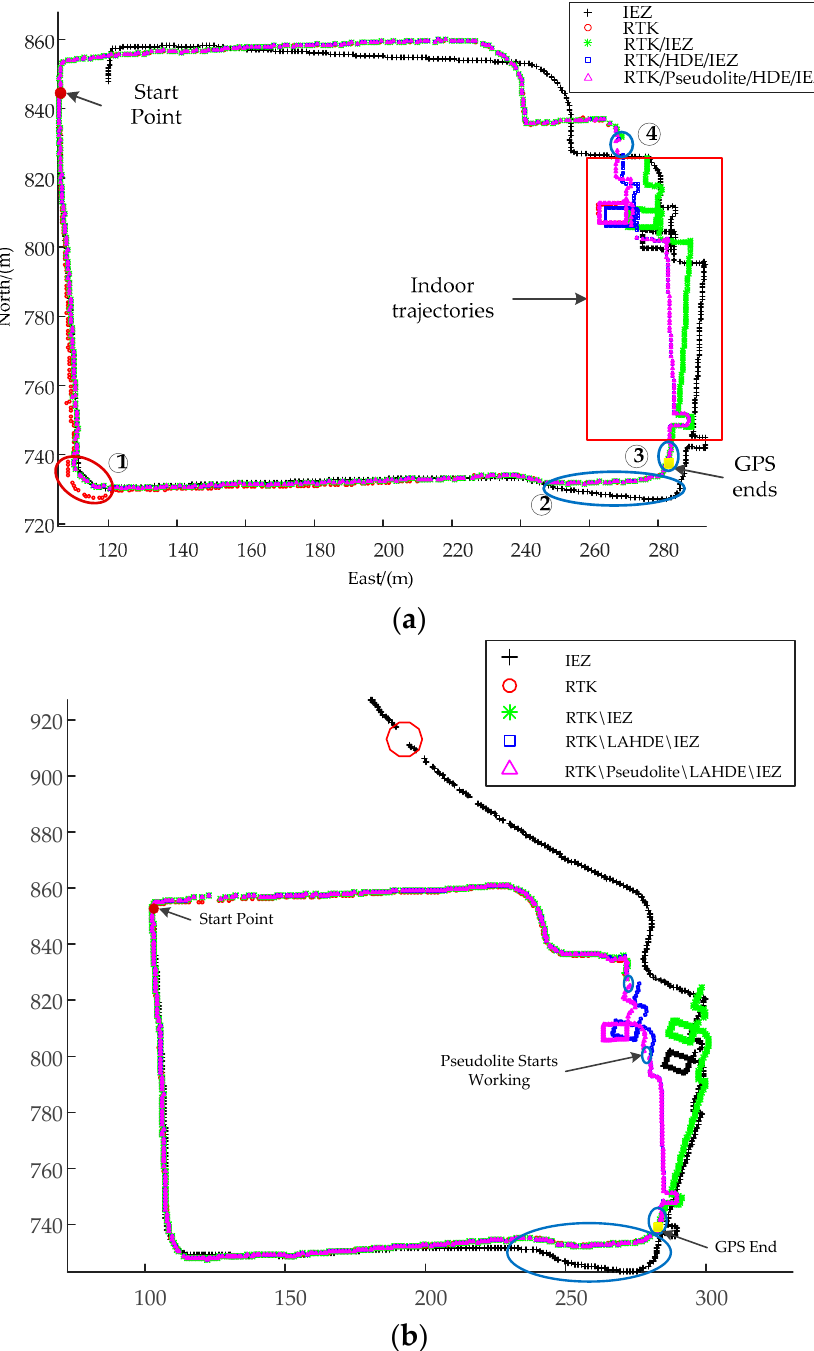
Figure 11 . The generated trajectories. ( a ) The trajectories of Person A. ( b ) The trajectories of Person B.